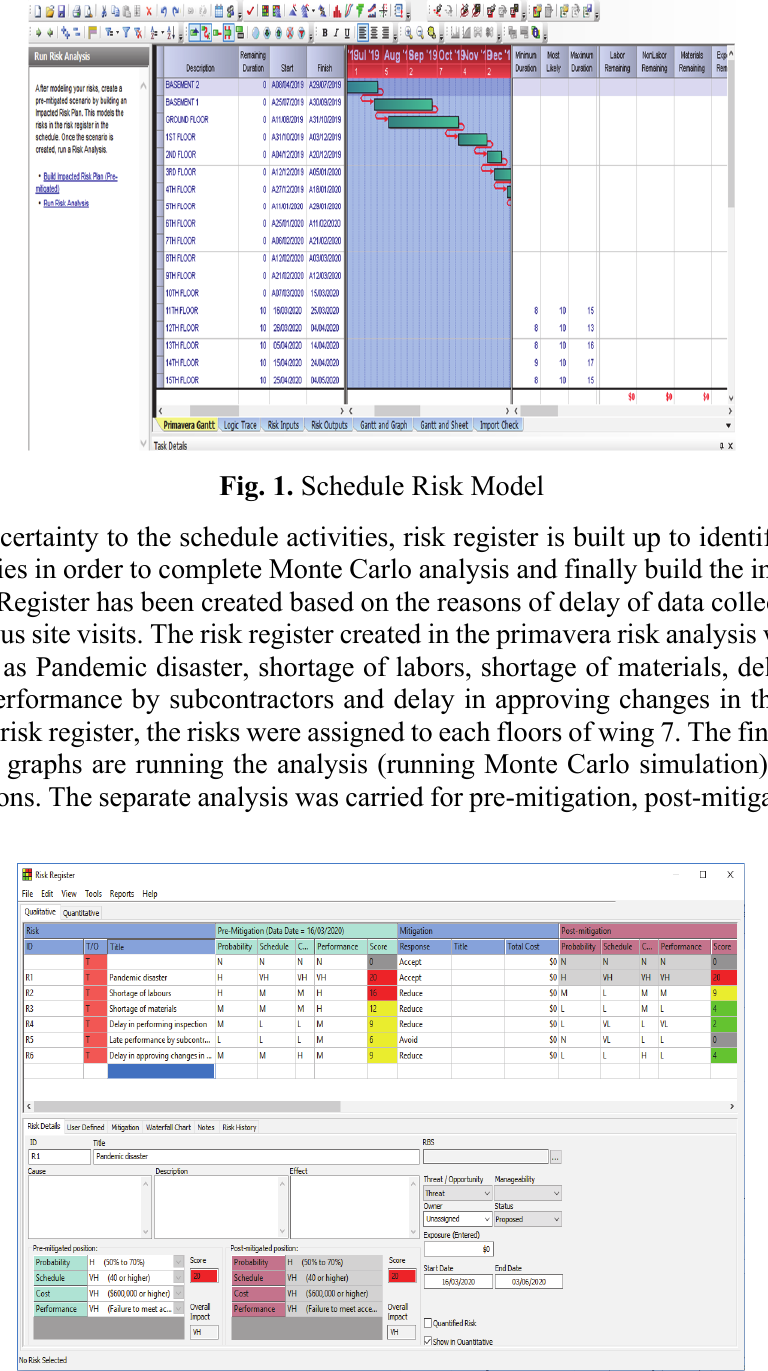
Fig. 2. Risk Register for Schedule Risk